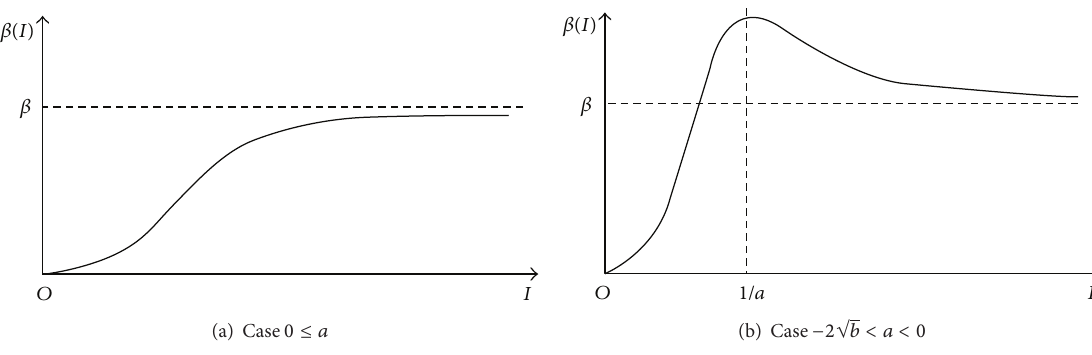
Figure 1: The plotting for the contact transmission function 𝛽(𝐼)